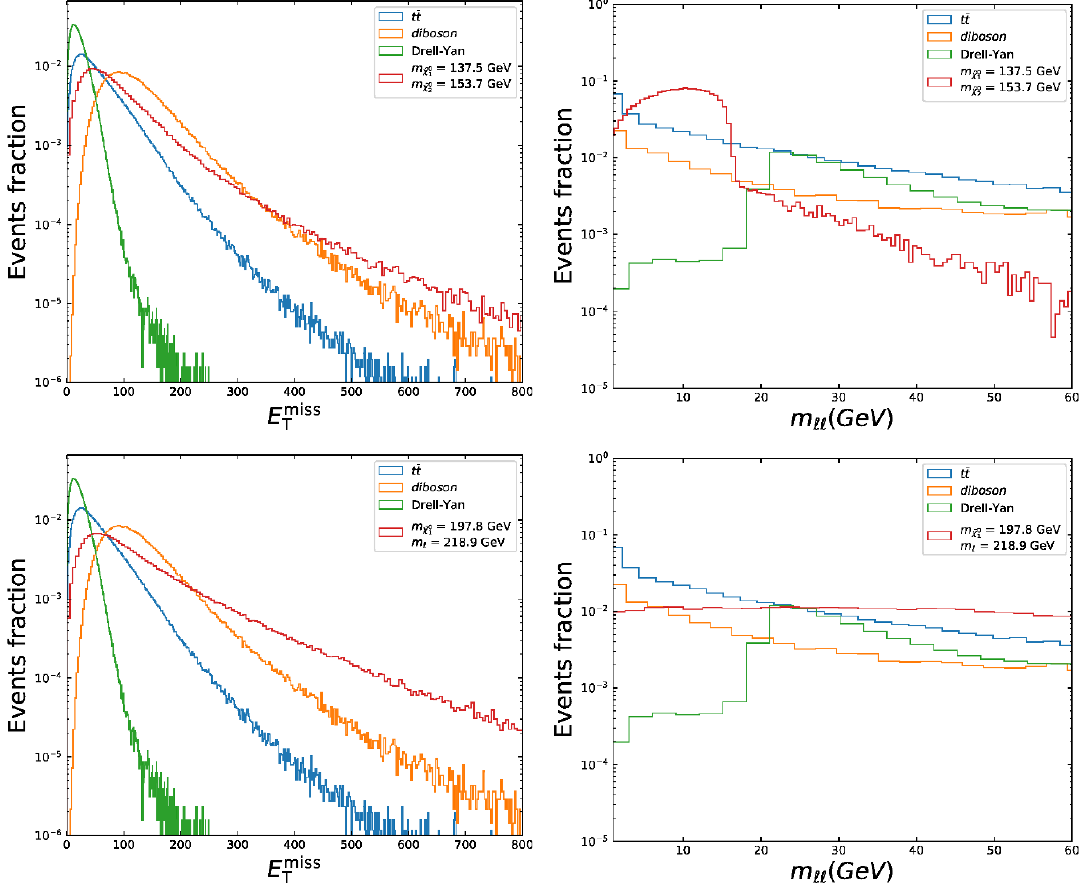
Figure 4 . The schematic diagrams of the wino pair production process pp ! j ~ (cid:31) 0 scenario (left panel) and the slepton pair production process pp ! j ~ ‘ ~ ‘ (cid:3) (~ ‘ = ~ e 1 ; ~ (cid:22) 1 ) in the BHL scenario (right panel).